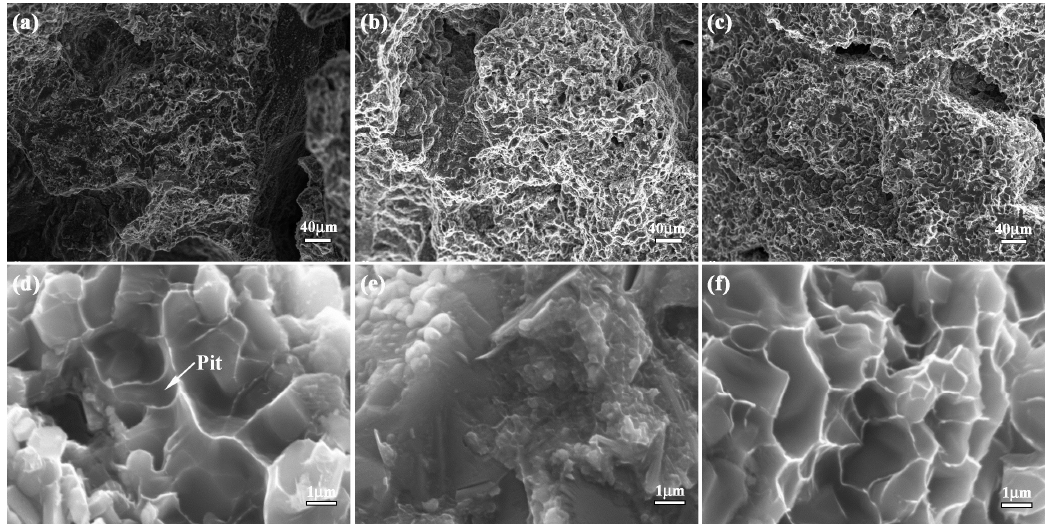
Figure 7. Flexural appearance of bionic layered composite ( a ) outer layer ( b ) middle layer ( c ) inner layer ( d ) magnified microstructure of ( a ); ( e ) magnified microstructure of ( b ); and ( f ) magnified microstructure of ( c ).